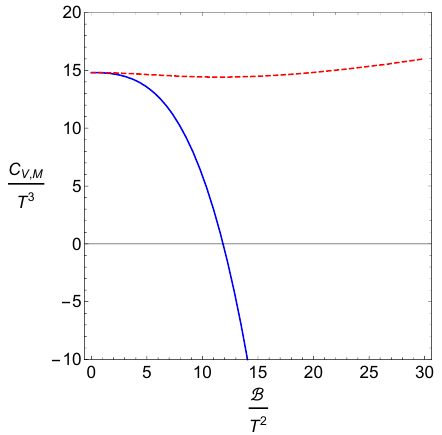
Figure 9 . Dimensionless specific heat at fixed magnetisation C V,M /T 3 as a function of b = B /T 2 (blue solid line), compared against the dimensionless specific heat at fixed magnetic field C V, B /T 3 (red dashed